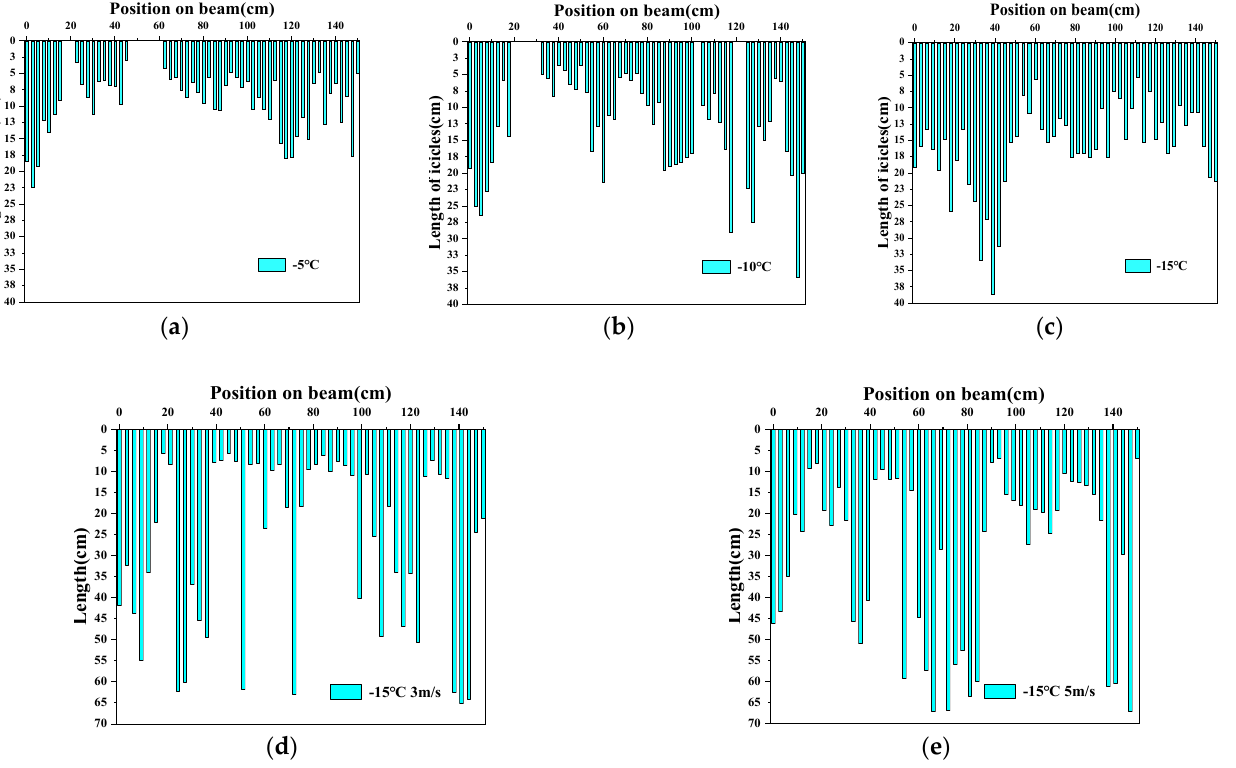
Figure 10. The icicle histograms: ( a ) − 5 °C, ( b ) − 10 °C, ( c ) − 15 °C, ( d ) − 15 °C and 3 m/s, ( e ) − 15 °C and 5 m/s.